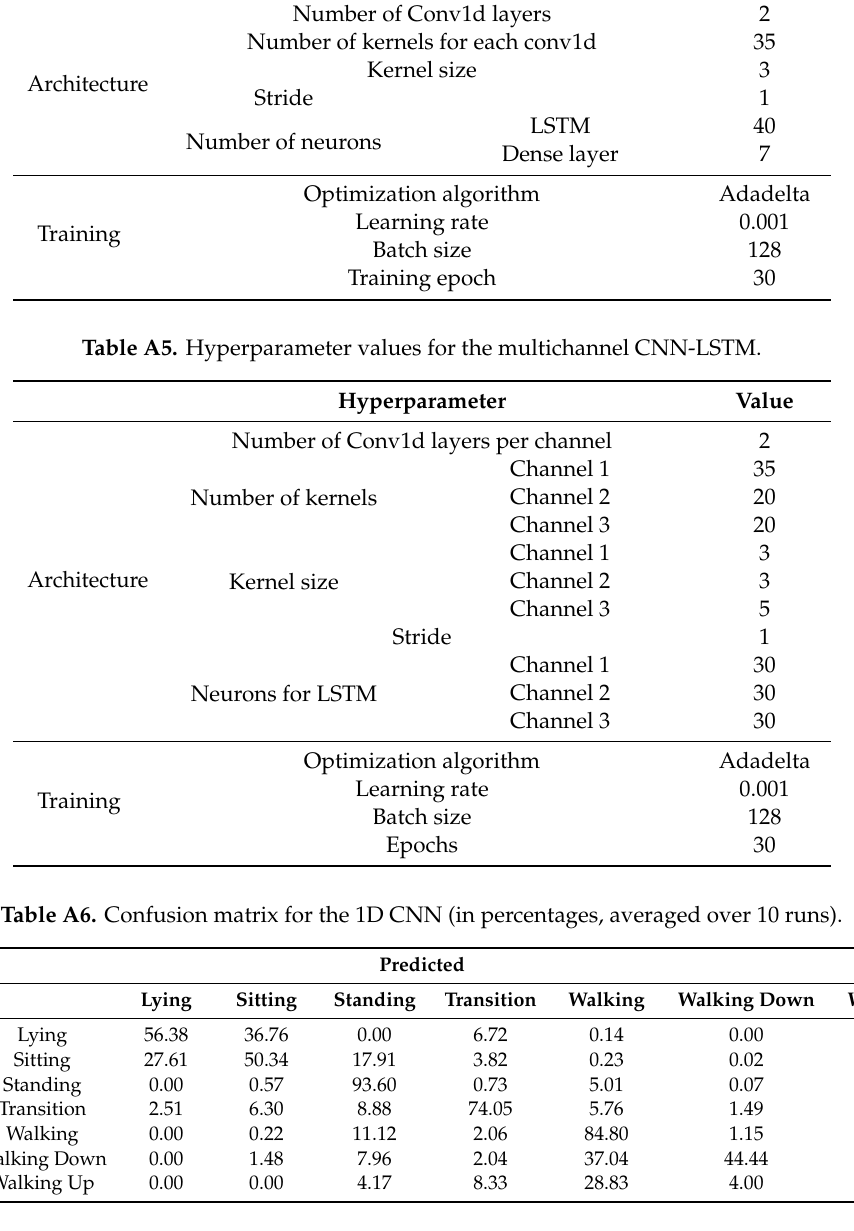
Table A7. Confusion matrix for the multichannel CNN (in percentages, averaged over 10